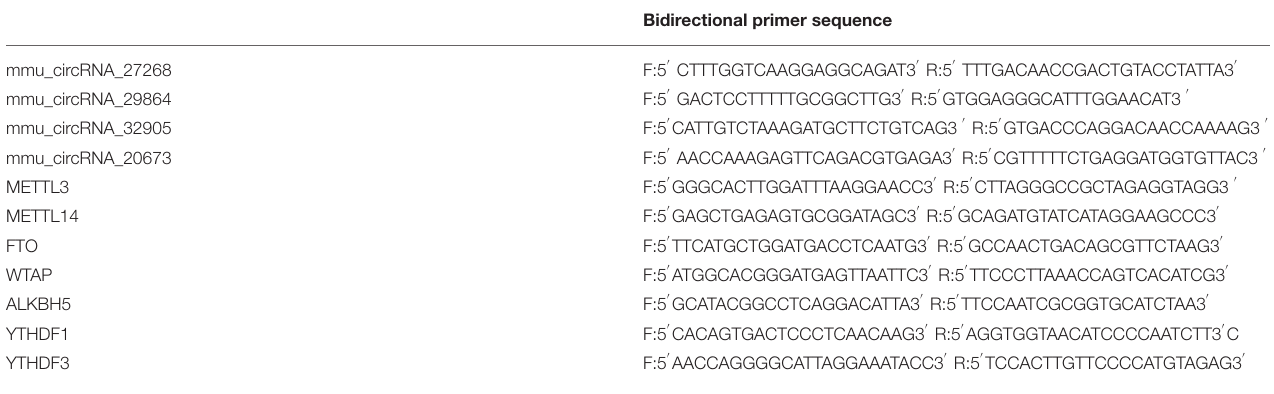
Bidirectional primer sequence